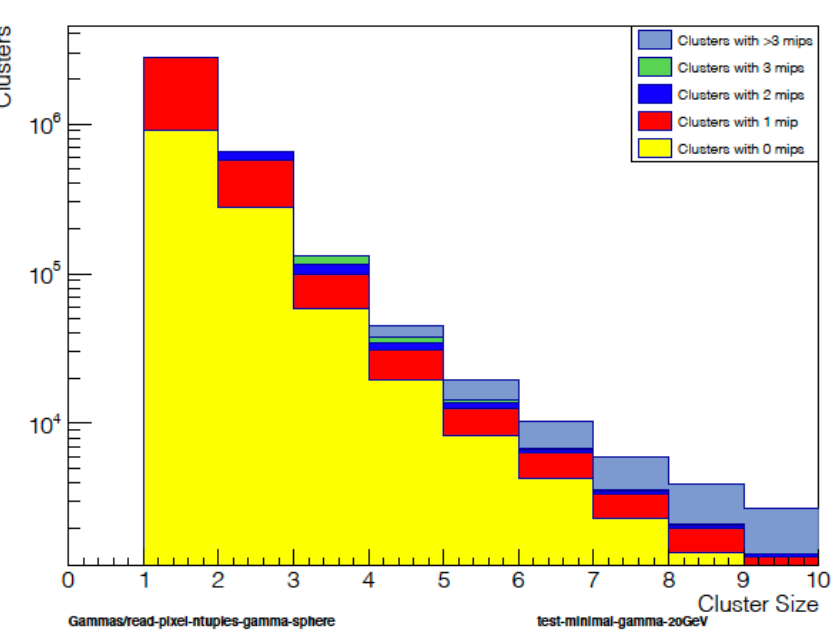
Figure 7. Distribution of cluster counts for 2000 showers from 20 GeV gammas, and the number of MIPs contained within specific cluster